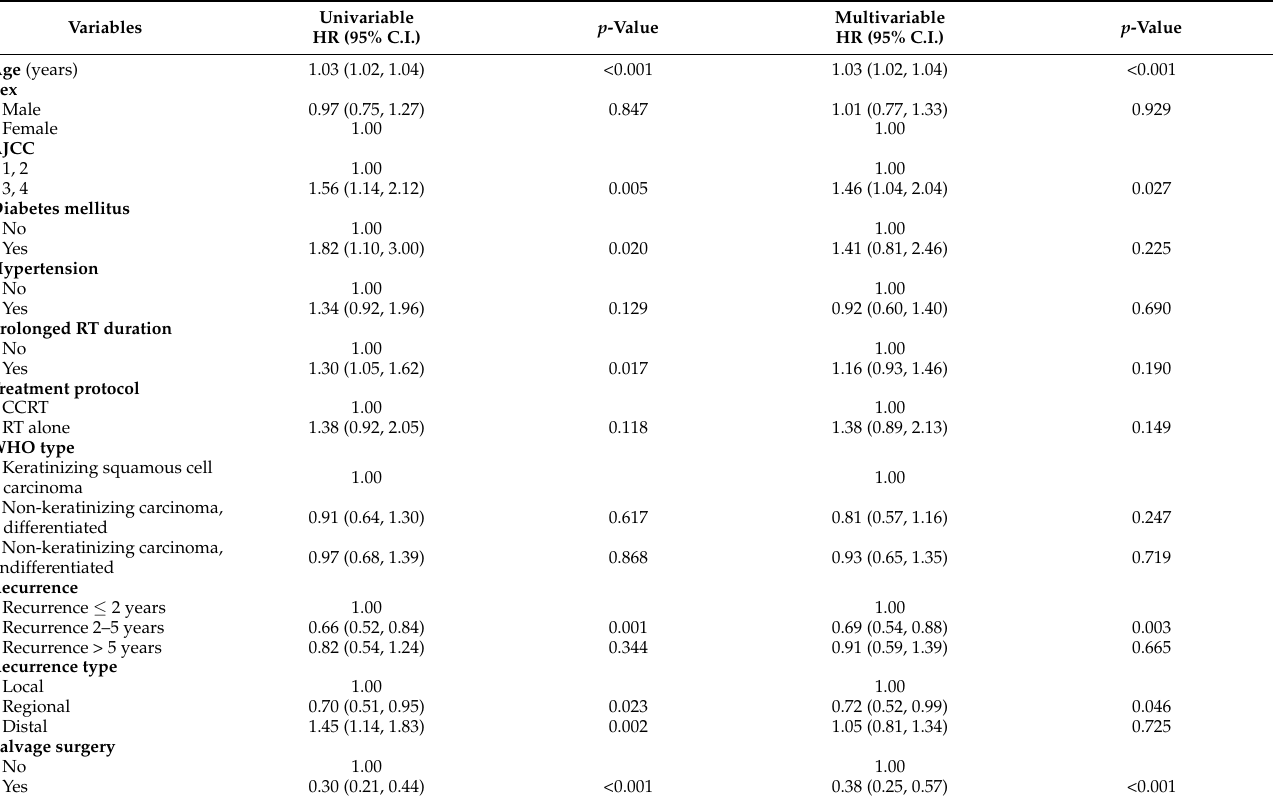
Figure 3. Survival curve of recurrent groups with different time intervals: the patients with recurrence between two and five years had better overall survival ( a ), disease specific survival ( b ), and longer median survival time compared to other groups. The Kaplan-Meier method was used for the survival analysis, and the log-rank test was used to check the survival function. Table 4. Cox regression analysis of survival after tumor recurrence.